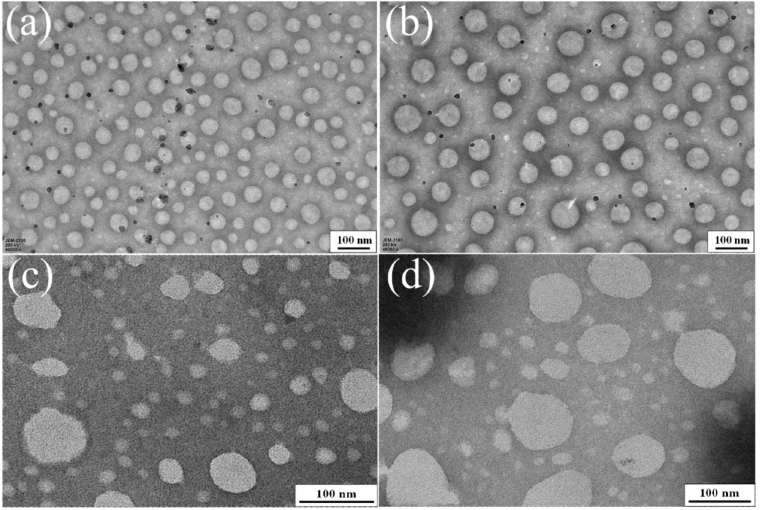
Figure 3. TEM images of PWPU and BWPU. ( a ) PWPU 5000 ; ( b ) PWPU 10,000 ; ( c ) BWPU 5000 ; ( d ) BWPU 10,000 ; (concentration 0.5